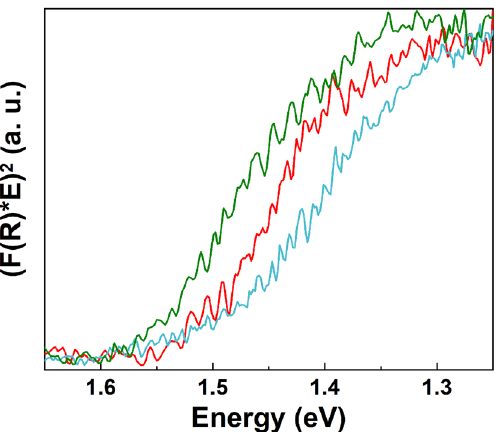
Figure 6. Kubelka–Munk function representations for: CuO_MIE (red curve), CuO–ZnO_MIE_1 (cyan curve) and CuO–ZnO_MIE_2 (olive curve).